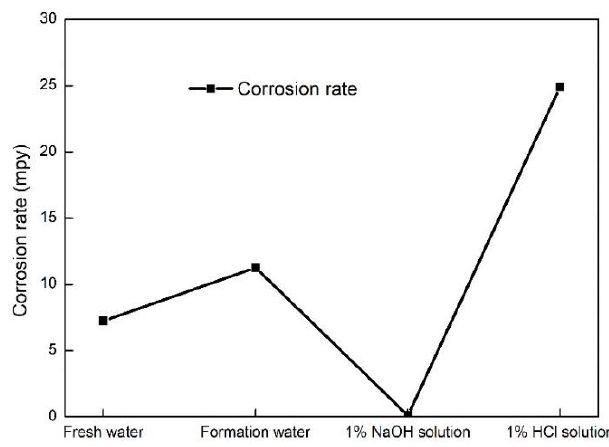
Figure 18. Corrosion rate of SCGPCS under the action of different erosive media.